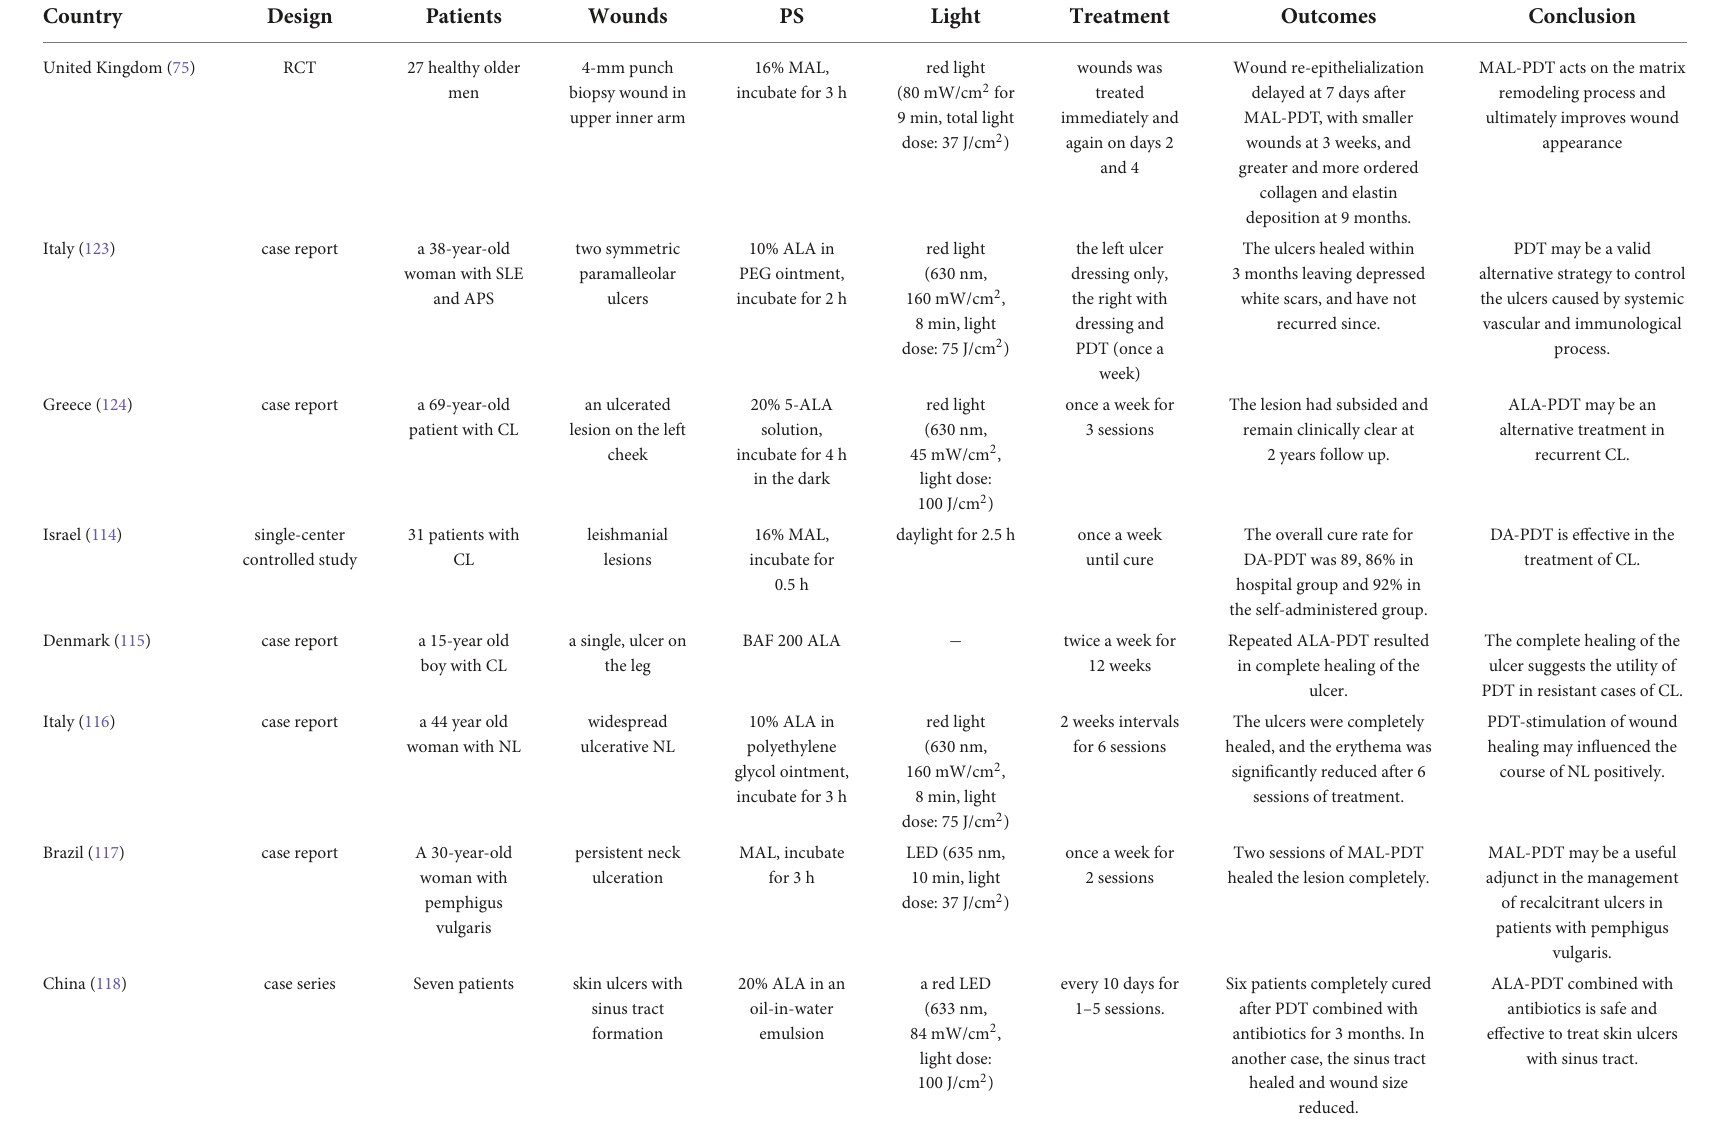
TABLE 3 Clinical studies involving PDT in other types of